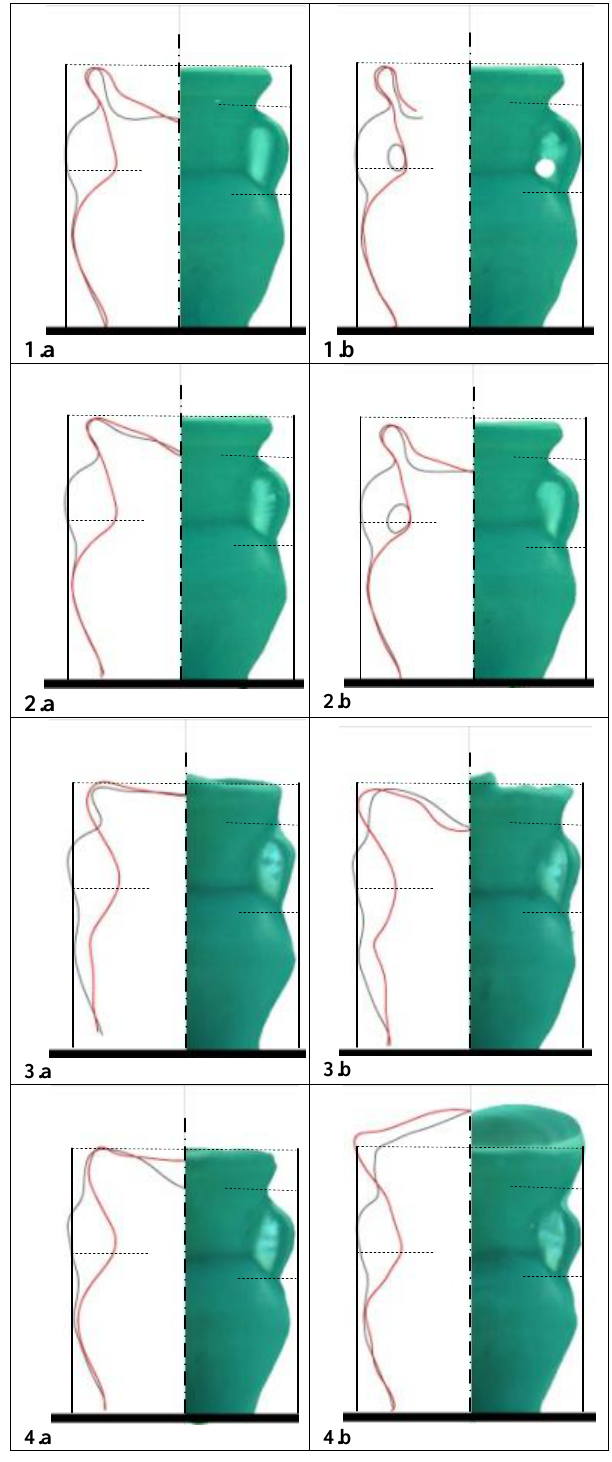
Table 2. Graphical representations of sections and 3D textured surfaces, with metric reference of the geometric elements measured on the reference